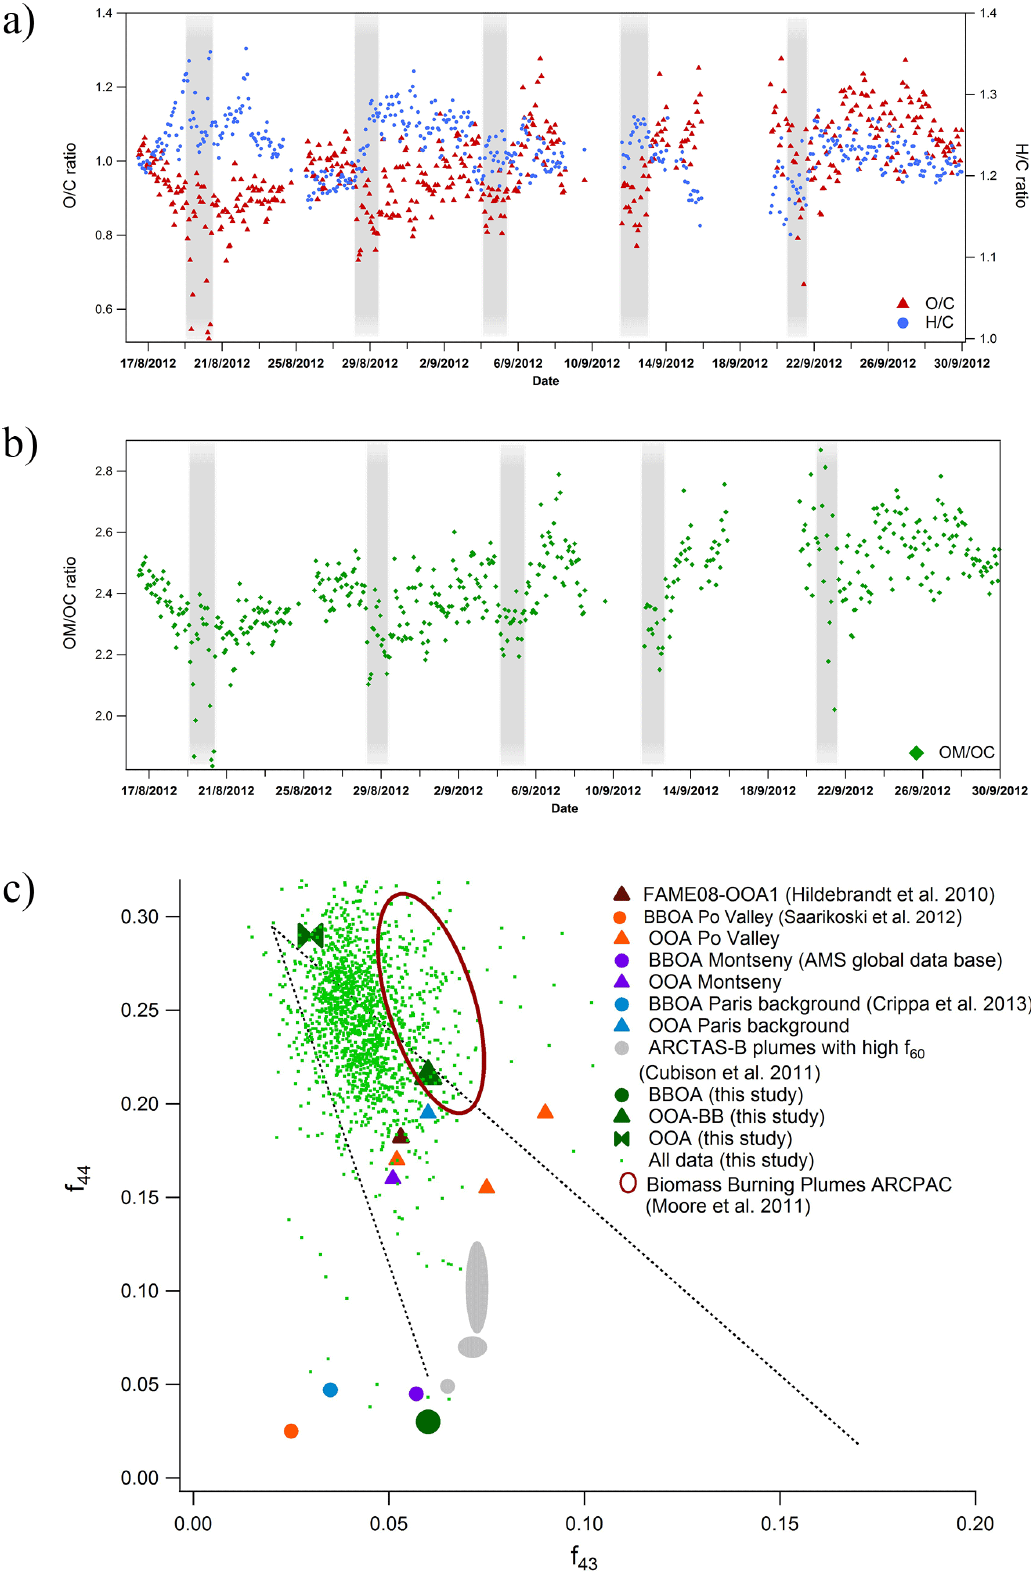
Fig. 4. Time series of atomic ratios of O/C and H/C (a) , the variation of the mass ratio of OM/OC (b) , and the fractional signals f 43 and f 44 of biomass-burning and oxygenated organic aerosol in our study and other studies (c)